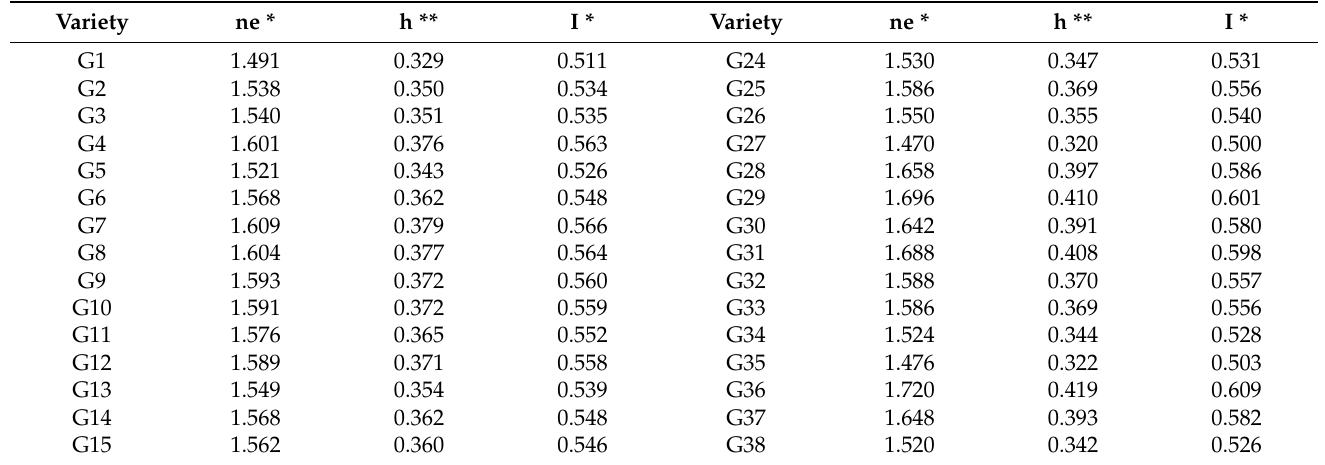
Table 4. Summary statistics for mean values for beans ( P. vulgaris L.) varieties assessed with 26 iBPS